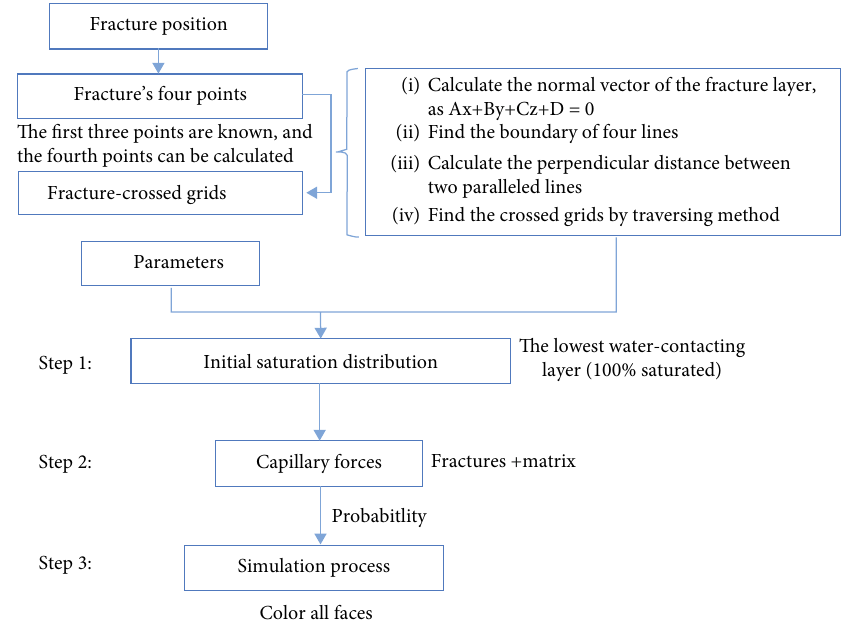
Figure 6: Work fl ow of the 3D simulation